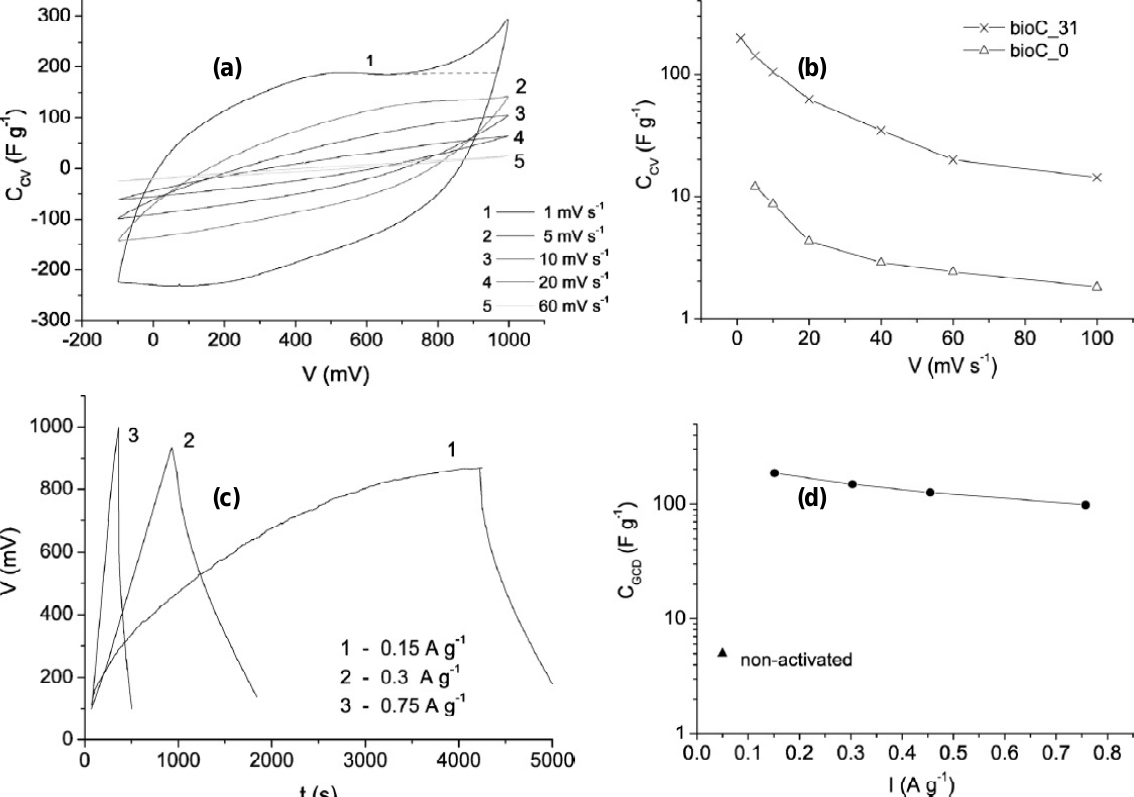
Fig. 9. Electrochemical testing results for monolith activated carbon bioC_31 in electrolyte 1 M H Cyclic voltammetry curves at different scan rates, b) dependence of maximum specific capacity on scan rate, c) galvanostatic charge-discharge curves at various current densities, d) specific capacitance as a function of current density, based on the charge–discharge curves.